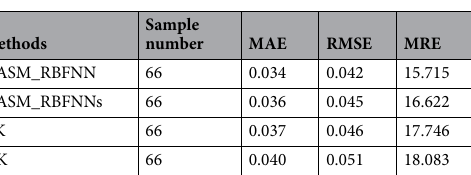
Table 3. Prediction errors of the different methods for the independent validation points. MAE, mean absolute error; RMSE, root mean square error; MRE, mean relative error; OK, ordinary kriging; RK, regression kriging; HASM_RBFNN, the combined method (HASM_RBFNN) developed using high-accuracy surface modelling (HASM) and radial basis function neural network (RBFNN) modelling, taking into account the spatial non- stationarity of the relationships between soil Cd and the auxiliary variables; HASM_ RBFNNs, the combined method (HASM_RBFNN), without taking into account the spatial non-stationarity of the relationships.